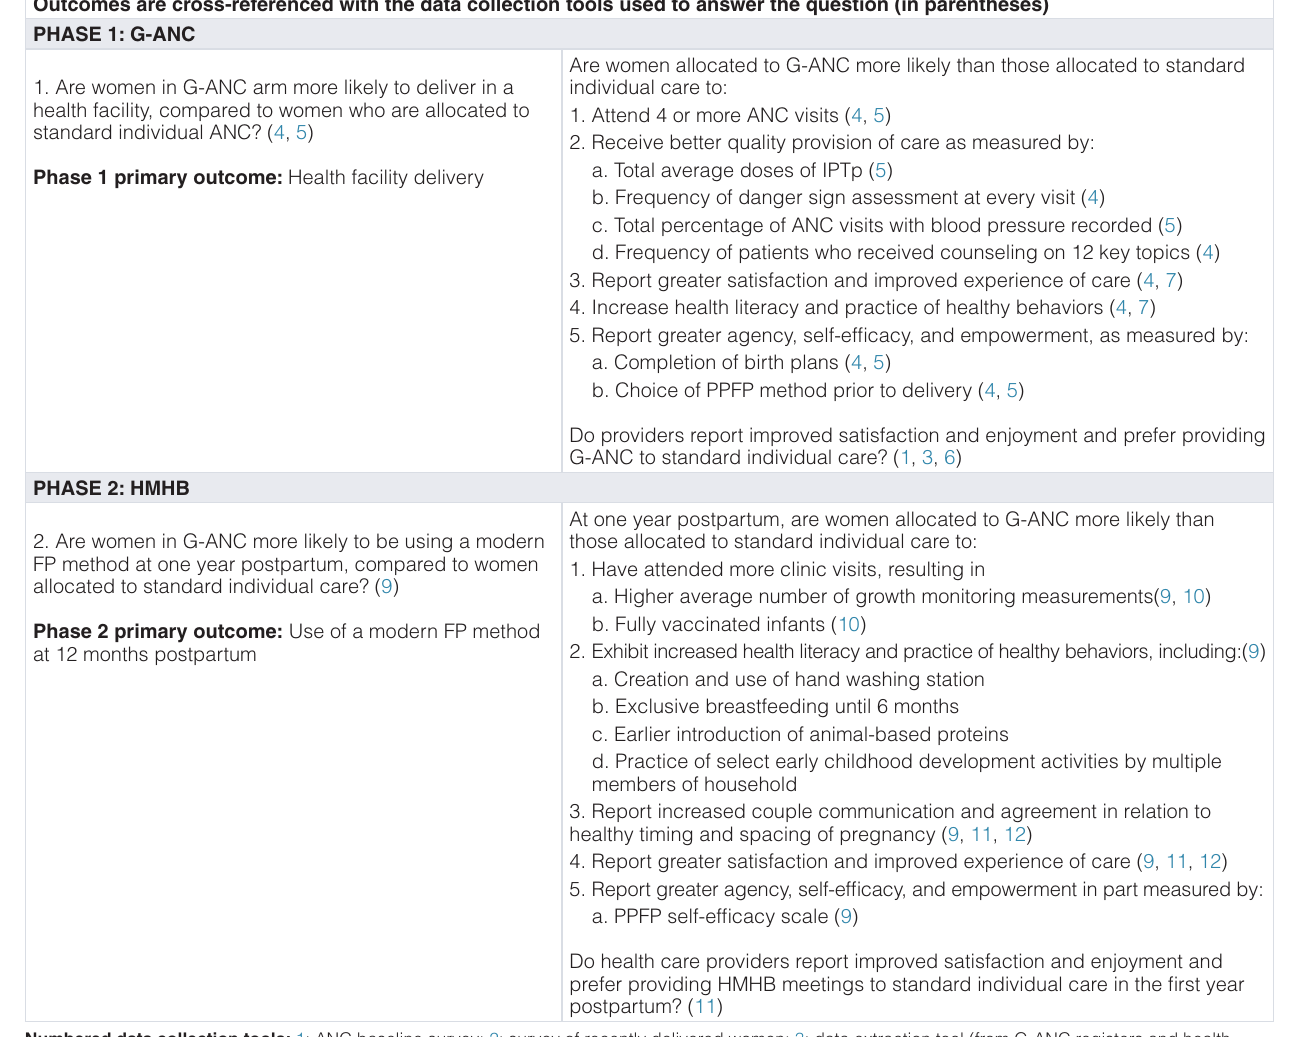
Table 5. Research questions and outcomes by study phase. Study research questions, outcomes and data collection tools stratified by study phase (1&2). Research Questions Secondary Research